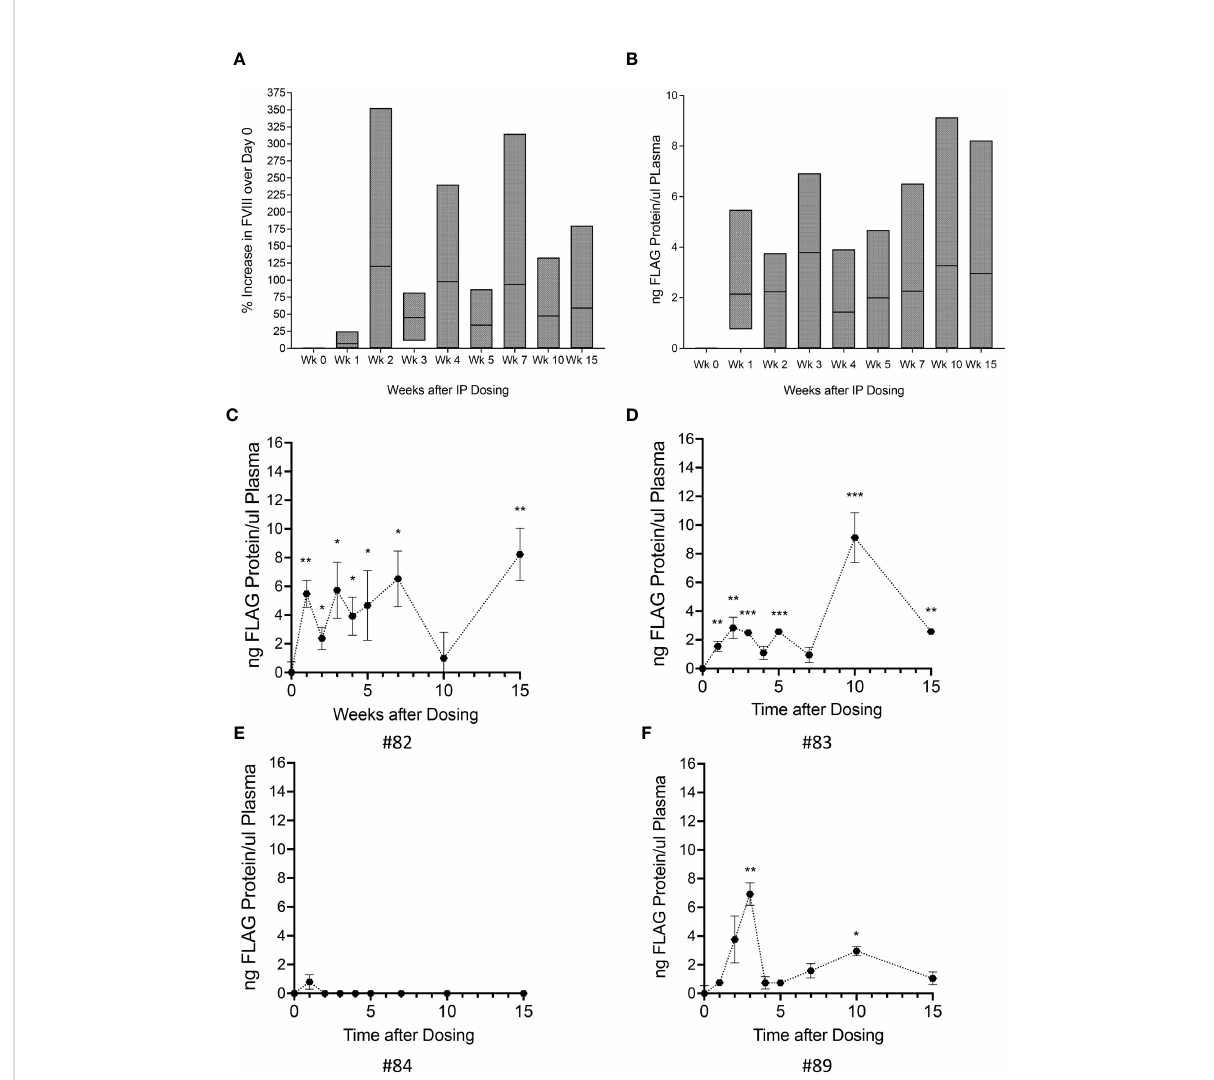
FIGURE 3 Administration of Autologous oFVIII-FLAG Producing MSCs Provide FVIII Protein in vivo. (A) Factor VIII activity measured in the plasma of all animals at weekly intervals after treatment with the autologous MSC-oFVIII-FLAG; the percent increase in FVIII activity over day 0 for each animal was calculated at each time point and the min to max increase in FVIII activity in the group of animals is shown (n=4 biological replicates). (B) Min to max levels oFVIII-FLAG protein in the plasma of animals after treatment measured by FLAG-speci fi c ELISA (n=4 biological replicates, n=3 technical replicates). (C – F) Levels oFVIII-FLAG protein in the plasma of each individual animal measured by FLAG-speci fi c ELISA (n=3) *p < 0.05, **p < 0.005, ***p < 0.0005 compared to week